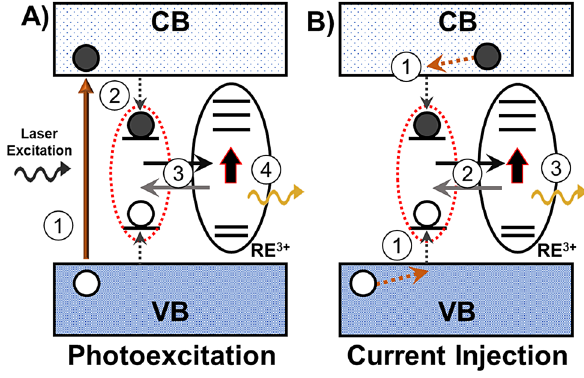
Figure 5: Model for defect-trap – mediated energy transfer (ET) in rare earth (RE)